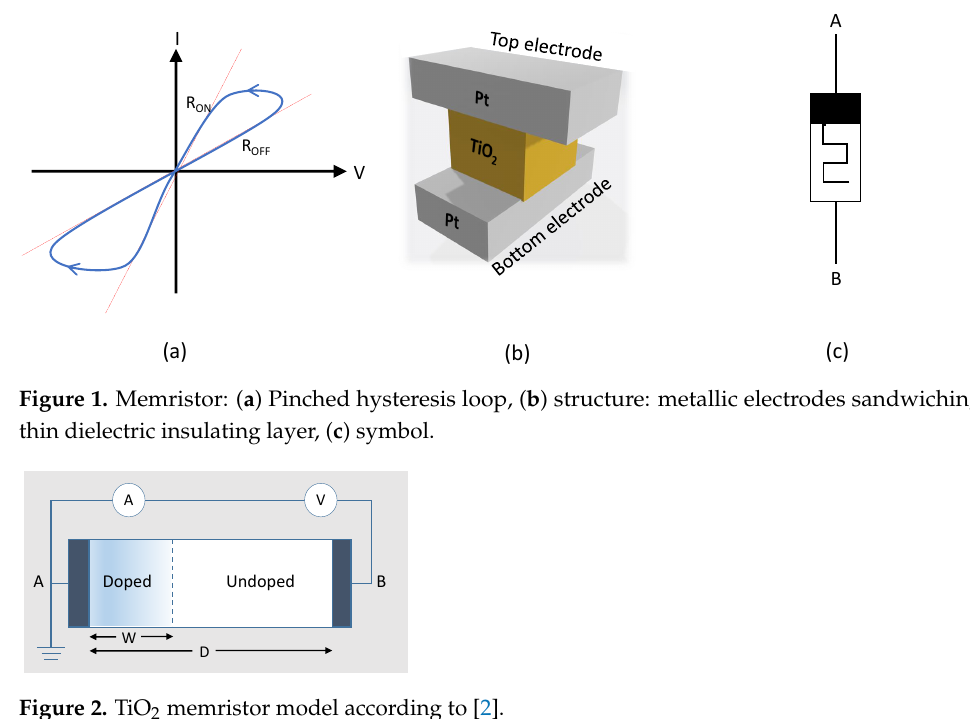
Figure 2. TiO 2 memristor model according to